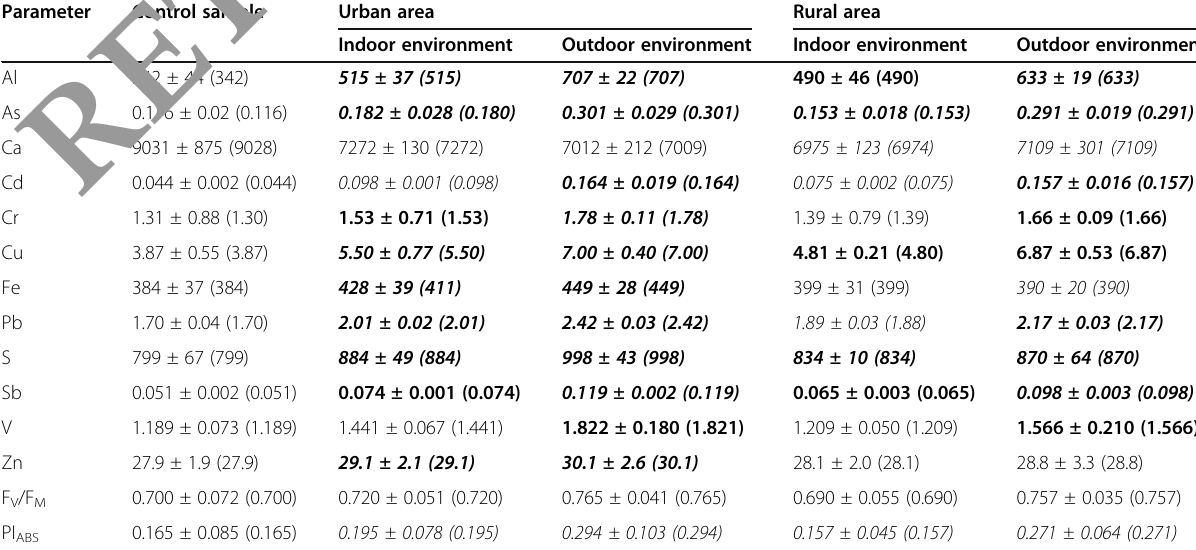
Table 1 Element concentrations ( μ g g − 1 ) and photosynthetic parameters (potential quantum yield of primary photochemistry — F V / F M and performance index — PI ABS ) in the lichen Usnea minaminensis before and after indoor or outdoor exposure (average ± standard deviation (median)). As a first step, we checked whether a significant accumulation (or variation of photosynthetic parameters) occurred, and the values in bold are significantly higher than the control samples; in such cases, we checked whether samples in the same locality differ according to their indoor/outdoor exposure (pairs in italics) (Mann-Whitney U test, p <